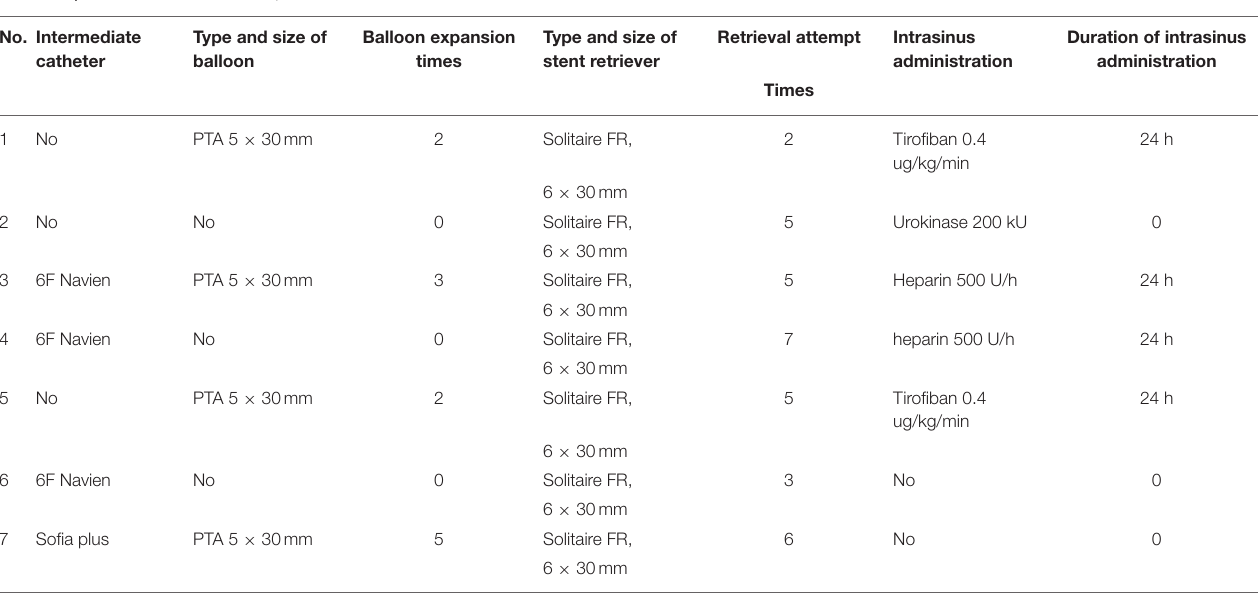
TABLE 2 | Clinical data of the seven